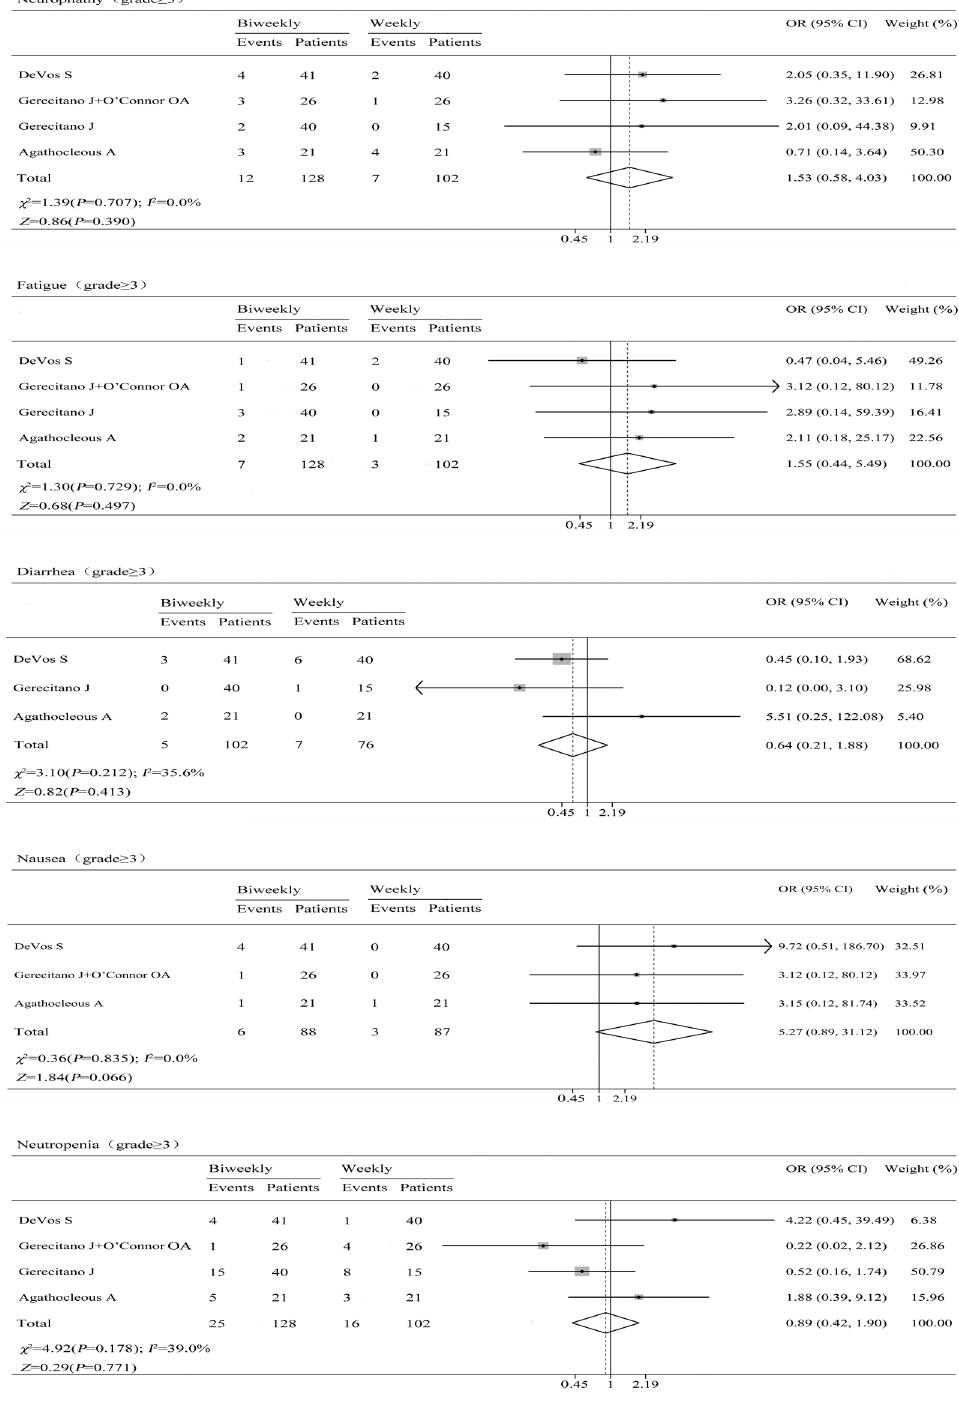
PLOS ONE | https://doi.org/10.1371/journal.pone.0177950 May 22,